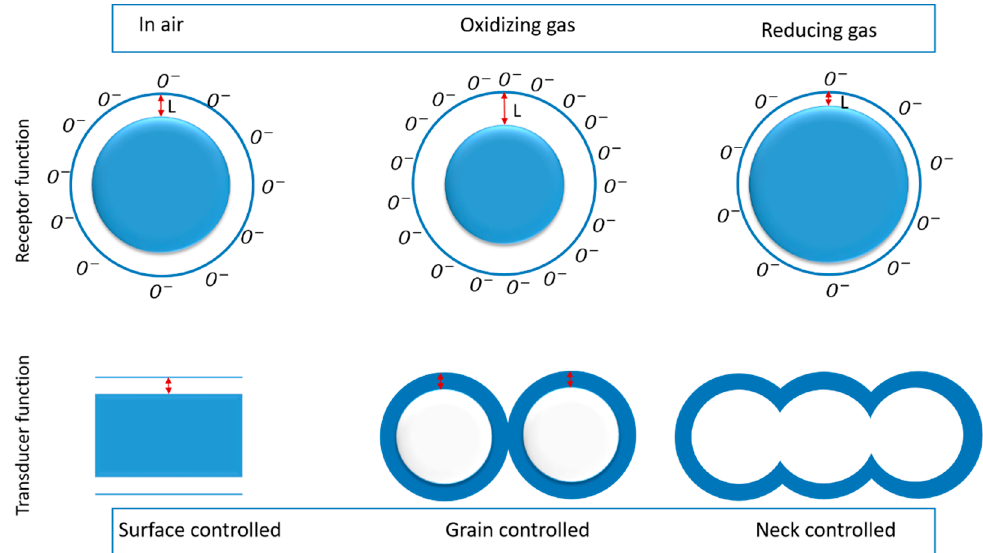
Figure 8. Schematic representation of gas sensing at different modes.